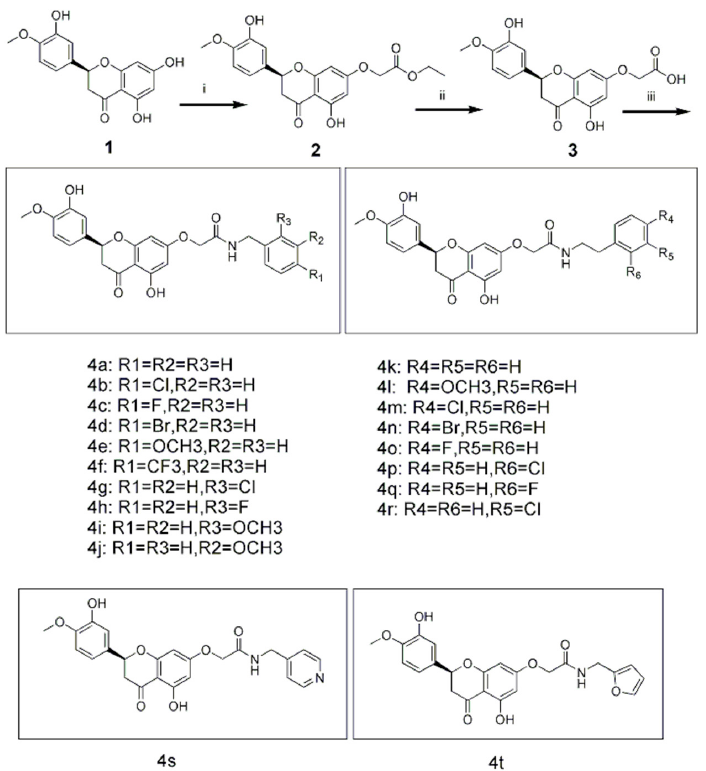
Scheme 2. Synthesis of hesperetin derivatives. Reagents and conditions : (i) ethyl bromoacetate, K 2 CO 3 , I 2